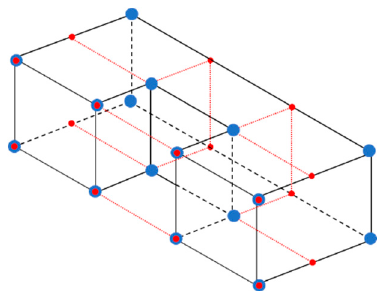
Figure 17. Schema of the intersection problem for Scenario 2: real vertexes in blue, virtual intersections in red.